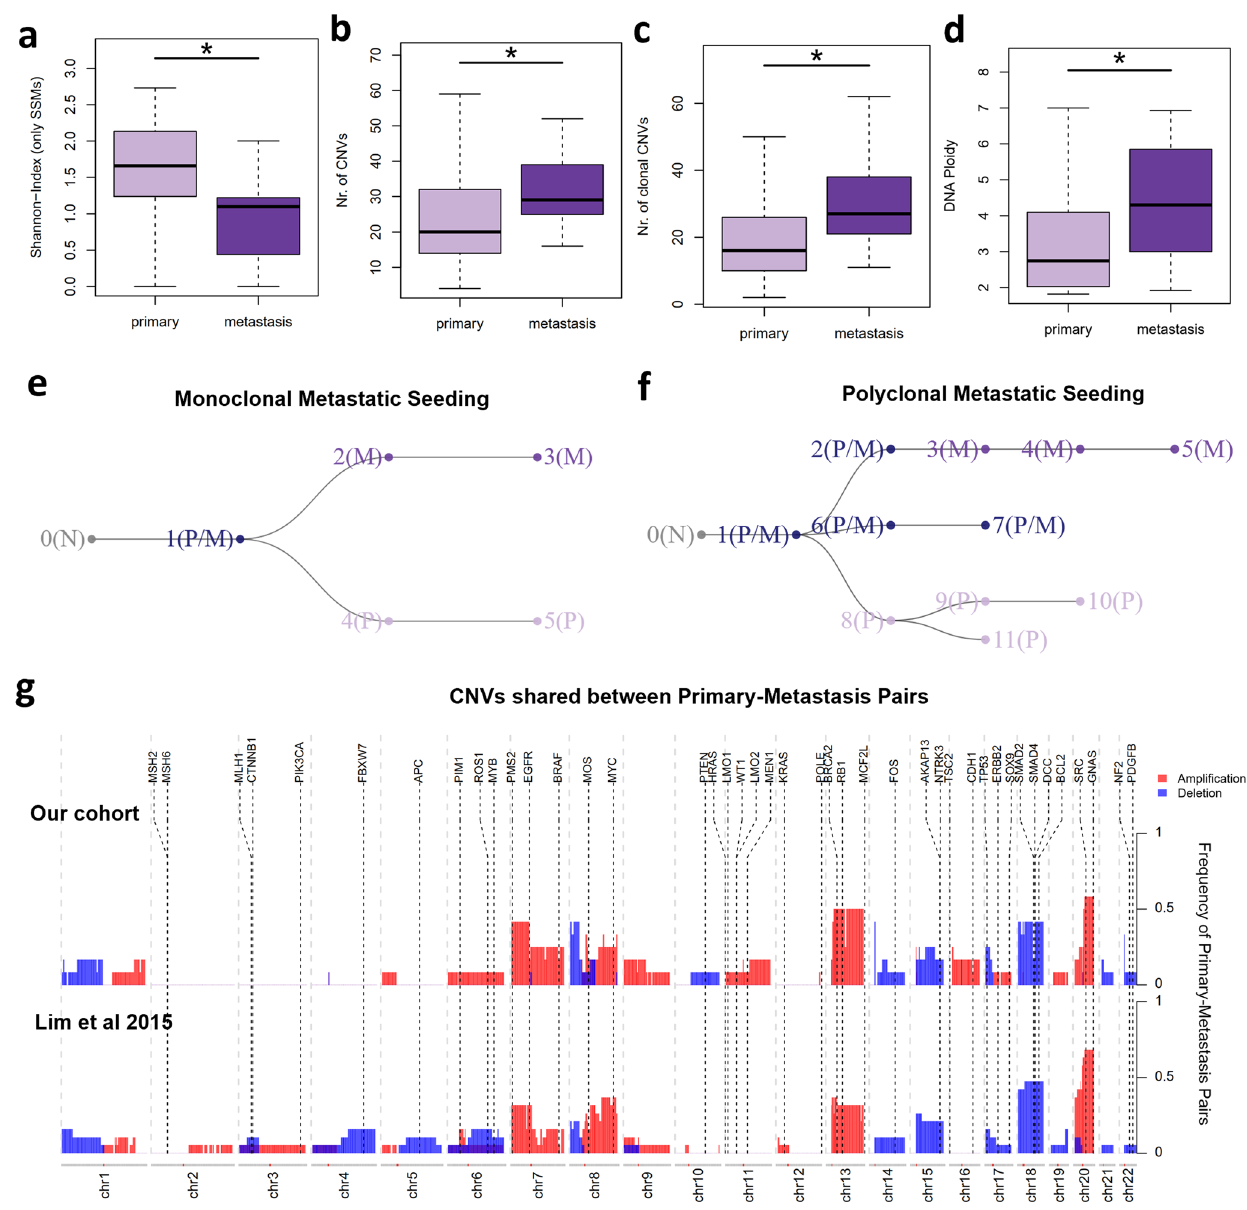
Fig. 6 Clonal Diversity and Metastasis Development. a Distribution of the Shannon-Index values based on Expands clonal composition for early primary tumors ( n = 112) and metastasis ( n = 12). b – d Amount of total CNVs ( b ), clonal CNVs ( c ) and DNA ploidy ( d ) for early primary tumors and metastasis. e , f Phylogenetic trees depicting subclonal expansion for a primary-metastasis pair with monoclonal ( e ) and polyclonal metastatic seeding ( f ). The subclones are identi fi ed with the respective number and the containing sample: normal (N), primary tumor (P) and metastasis (M). g Frequencies of copy number events (separated in ampli fi cations and deletions) affecting different regions of the genome, in the paired primary-metastasis samples from our study ( n = 12) and the study of Lim et al. ( n = 19). Only events found in both the primary and its paired metastasis are displayed. Positions of known cancer-related genes are also